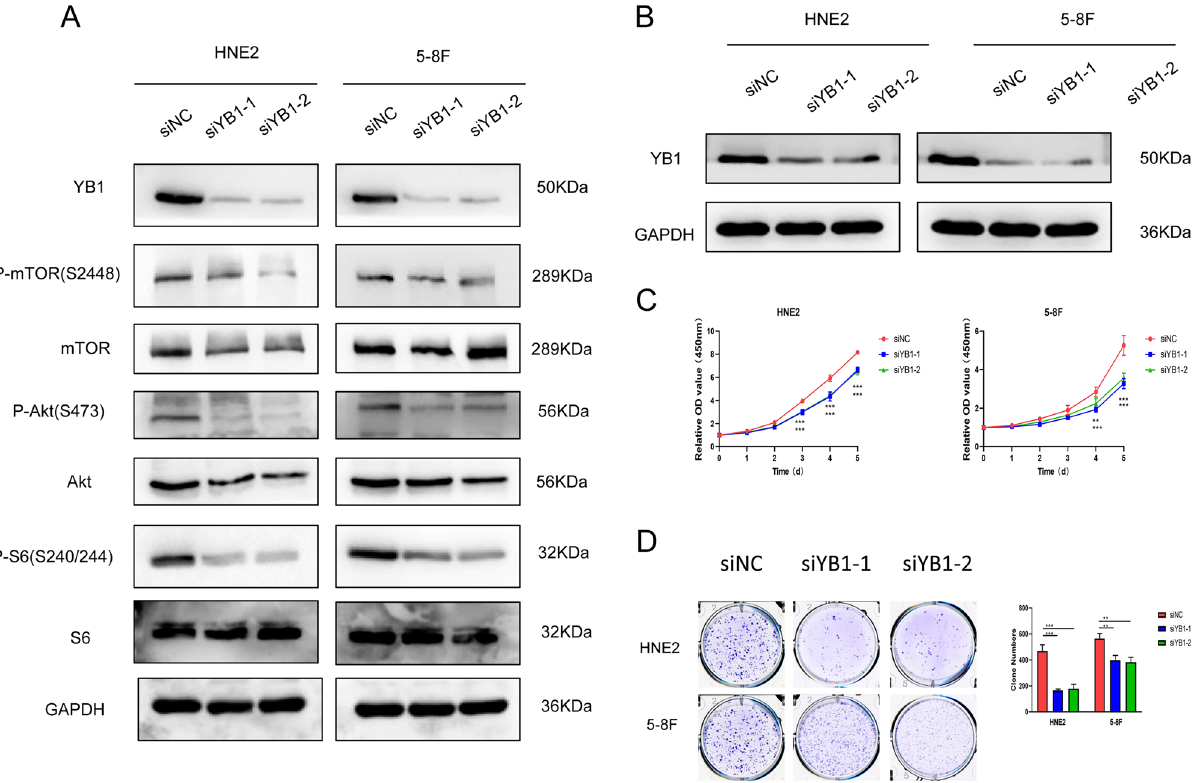
Figure 3. Knock down of YB1 inhibited Akt/mTOR signaling pathway and reduced NPC cell growth in vitro. ( A ) Knockdown of YB1 significantly inhibited AKT/mTOR signaling pathway. ( B ) The efficacy of knocking- down YB1 in HNE2 and 5-8F cell. ( C ) Knockdown of YB1 significantly inhibited the cell growth of HNE2 and 5-8F by CCK8 assay. ( D ) Knockdown of YB1 significantly inhibited the cell growth of HNE2 and 5-8F colony formation